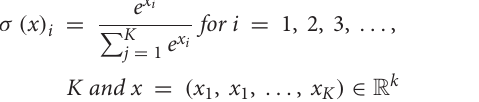
Learning (FL) subsystem, we have used four main criteria